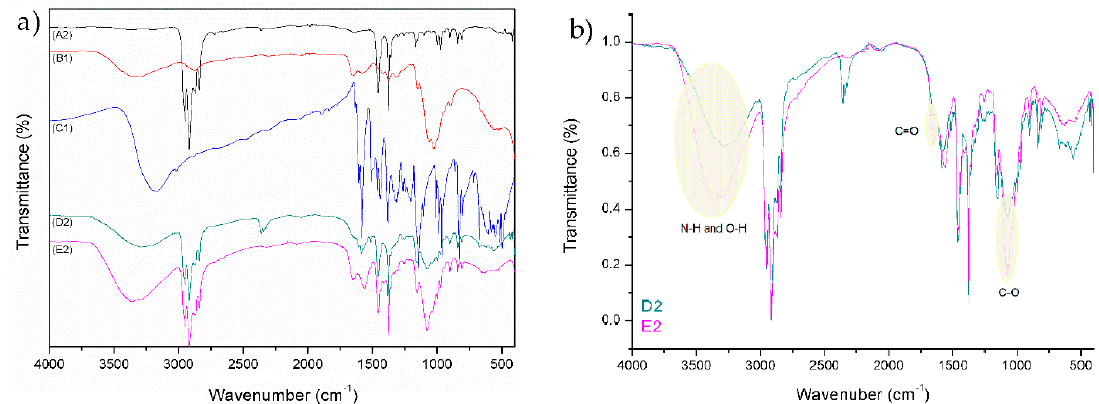
Figure 2. FTIR spectra of reference polyethylene (PE) (A1), chitosan (B1), resveratrol (C1), and different treated PE foils with application (D1 and E1) ( a ); comparison of the FTIR spectra between D1 and E1 (by normalizing) ( b ).